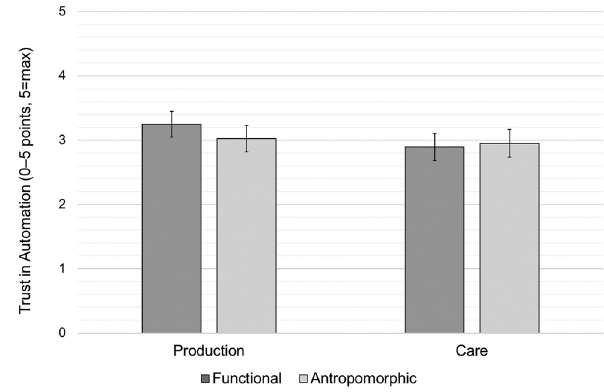
Figure 6: In fl uence of design and context on trust in the robot ( mean values with 95% con fi dence interval